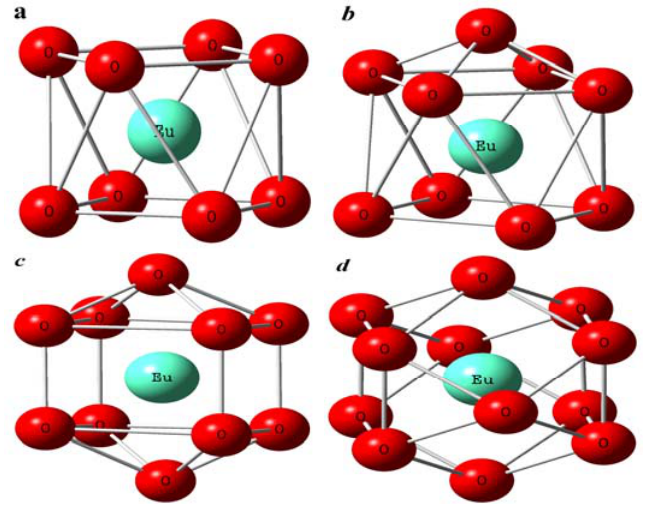
Figure 15. The different imaginary Eu(III) structures according to EXAFS results of the first order coordination shells. (a): dodecahedron; (b): mono-crown anti-tetragonal-prism; (c): bi-crown-dodecahedron; (d): icosahedron